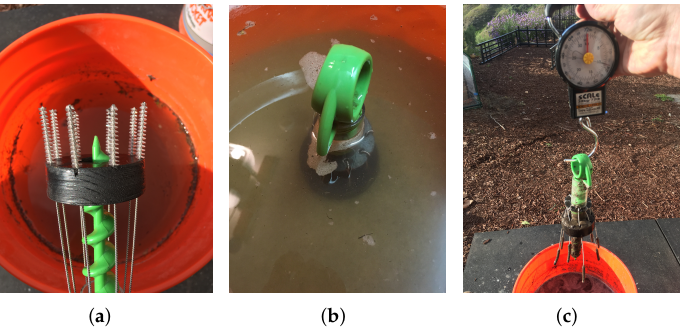
Figure 15. Testing sequence: ( a ) Wire root array ready for inject; ( b ) Anchor assembly fully rooted; ( c ) Vertical pull test